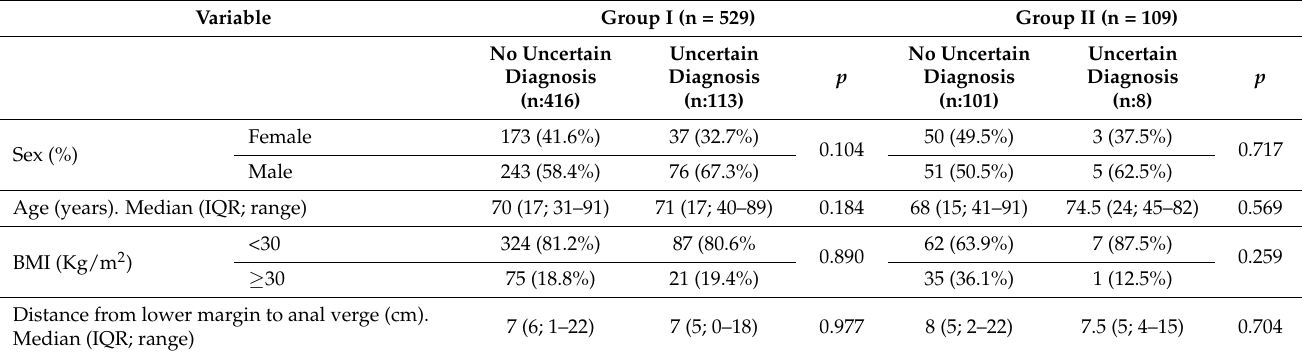
Table 3. Analysis of group I and II patients regarding diagnostic